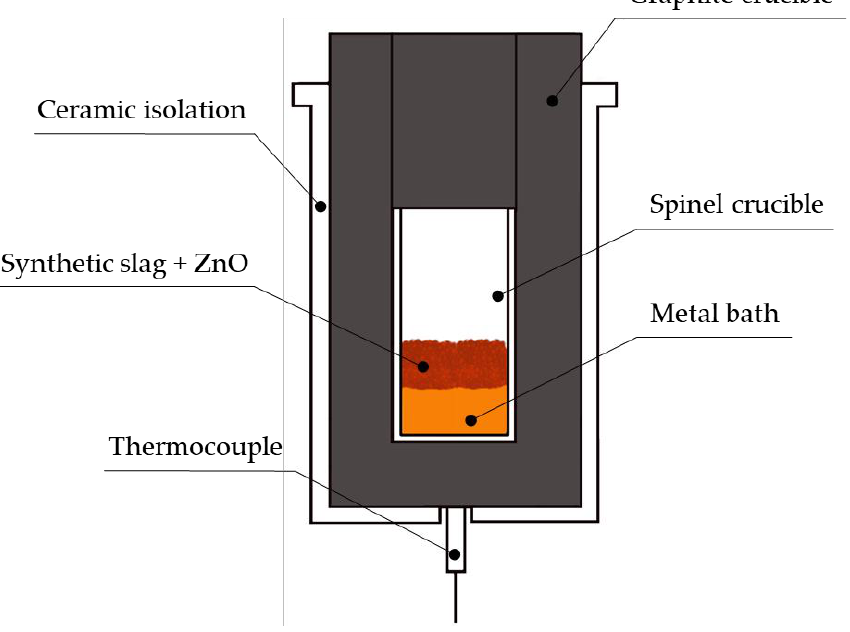
Figure 2. Experimental